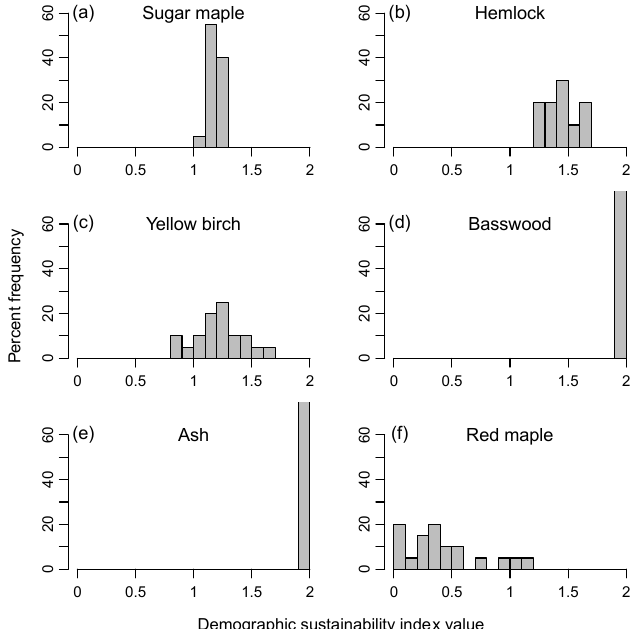
Figure 5. Demographic sustainability index for each of the principal species ( a – f ) based on 20 replicated simulations at the landscape scale (pooled measurements of all 70 plots). Simulations were constrained to maintain the initial observed numbers of 2–6 cm DBH saplings of each species in the field data, assuming a disturbance regime of background mortality only (Group 1d simulations).